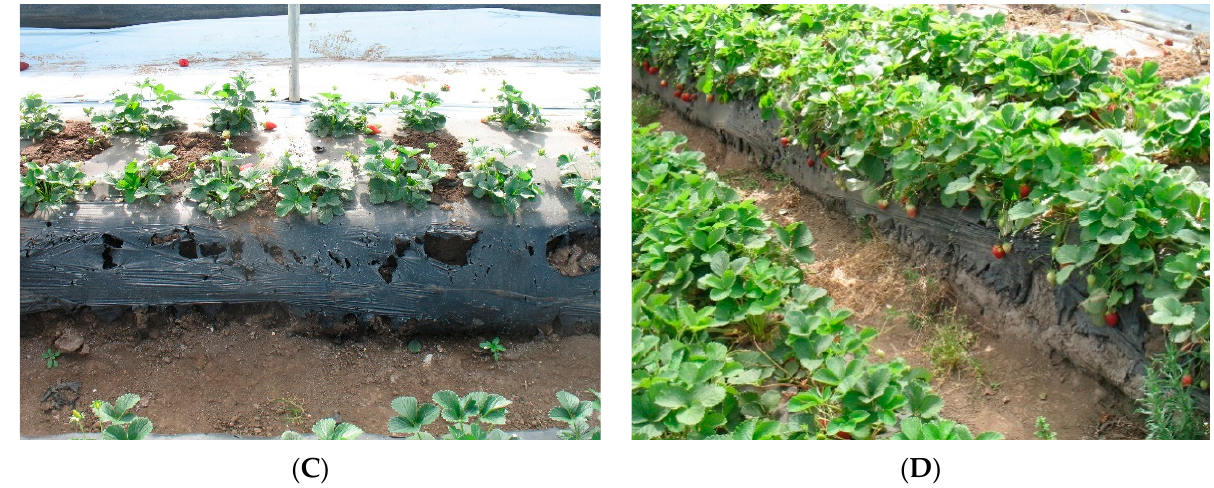
Figure 1. Rips and holes along the side walls and at bed bottoms for N18 mulch after 50 days after installation ( A ); Rips at the bottom of N5 mulched raised beds after 145 days from mulch installation ( B ); Rips at the bottom of N18 mulched raised beds after 145 days from mulch installation (on the left the N5 mulched raised beds) ( C ); N5 mulching film and crop development at the last harvest after 231 days mulch installation ( D ).